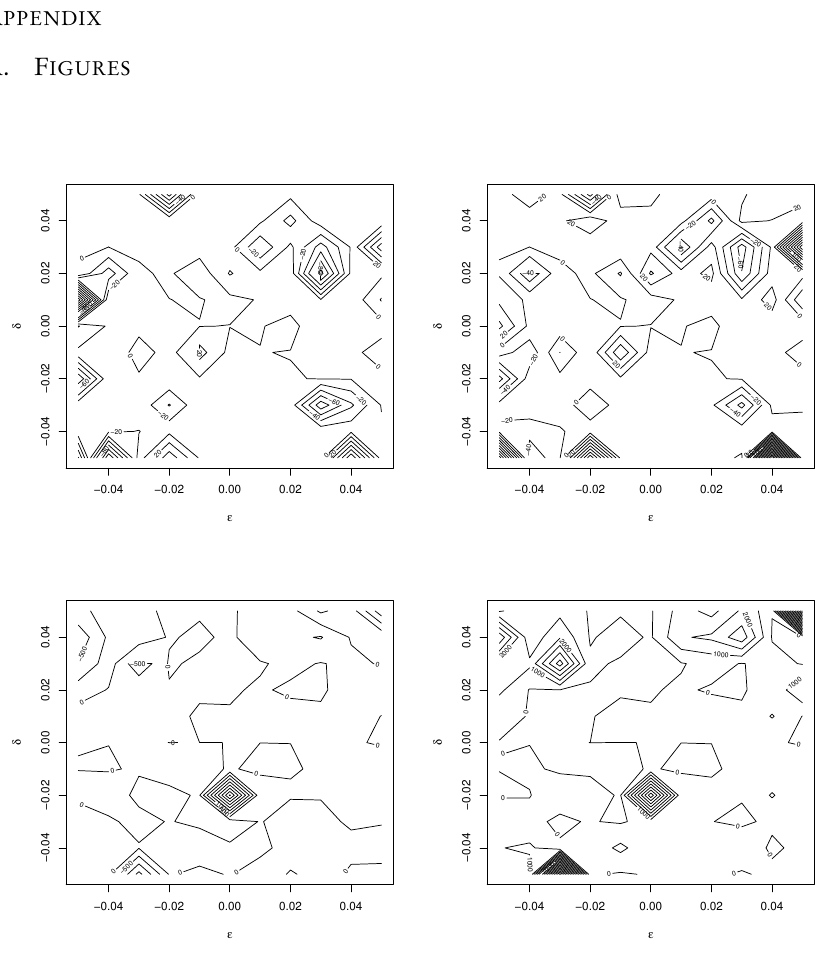
Figure 1 – Contours of the relative percentage changes in the bias of the estimator of α (top left), the MSE of the estimator of α (top right), the bias of the estimator of β (bottom left) and the MSE of the estimator of β (bottom right) when n =